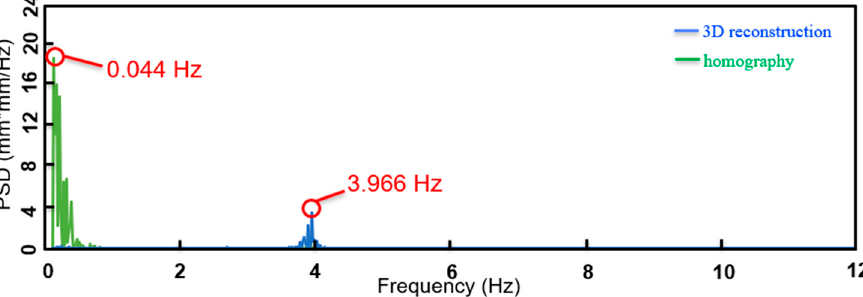
Figure 20. Comparison of PSD from 3D reconstruction and homography methods ( Z w = − 1000). Table 1. Frequencies obtained by two methods.